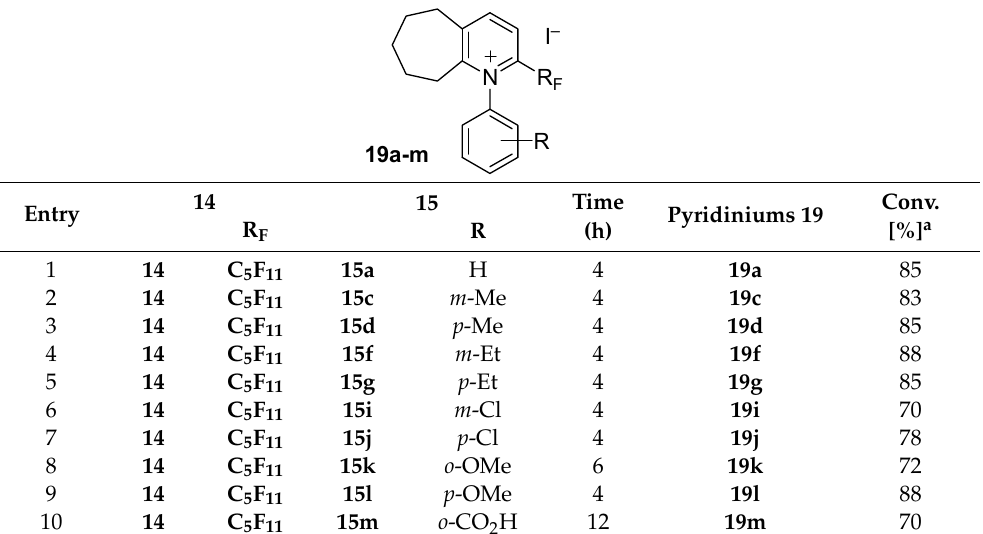
Table 3. Reaction conditions and conversions for the preparation of 2-trifluoromethyl-/2- perfluoroalkyl- N -(R-phenyl)-6,7,8,9-tetrahydro-5 H -cyclohepta[ b ]pyridiniums 19a – m , using cyclo- heptanone 16v as reactant.